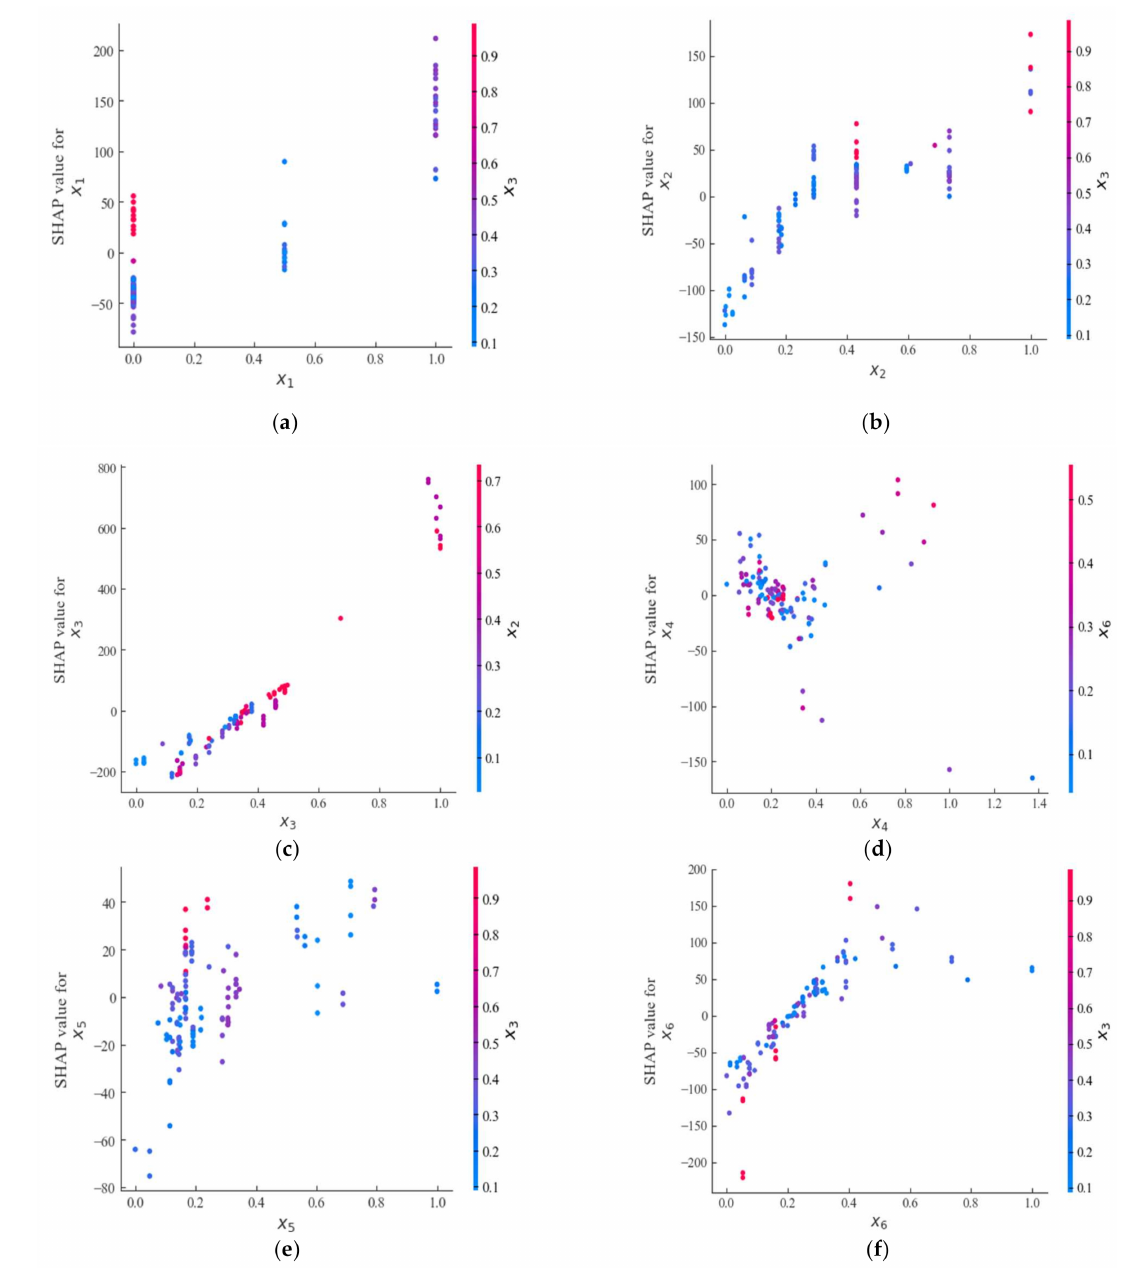
Figure 11. Feature dependence plots. ( a ) x 1 ; ( b ) x 2 ; ( c ) x 3 ; ( d ) x 4 ; ( e ) x 5 ; ( f ) x 6